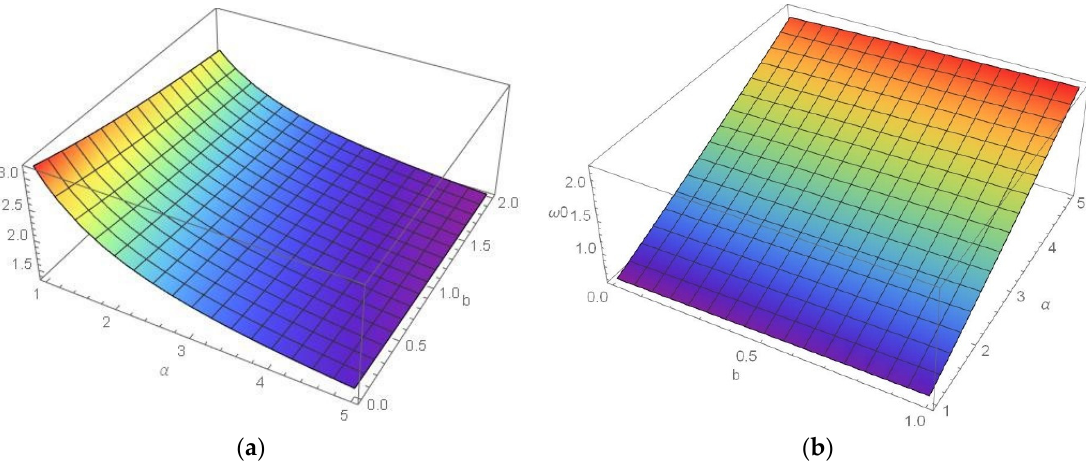
Figure 6. ( a ) A 0 - α - b and ( b ) ω 0 - α - b diagrams for constant a , k , F . Figure 6. ( a ) A ω 0 - α - b and ( b ) 0 - α - b diagrams for constant a , k , F